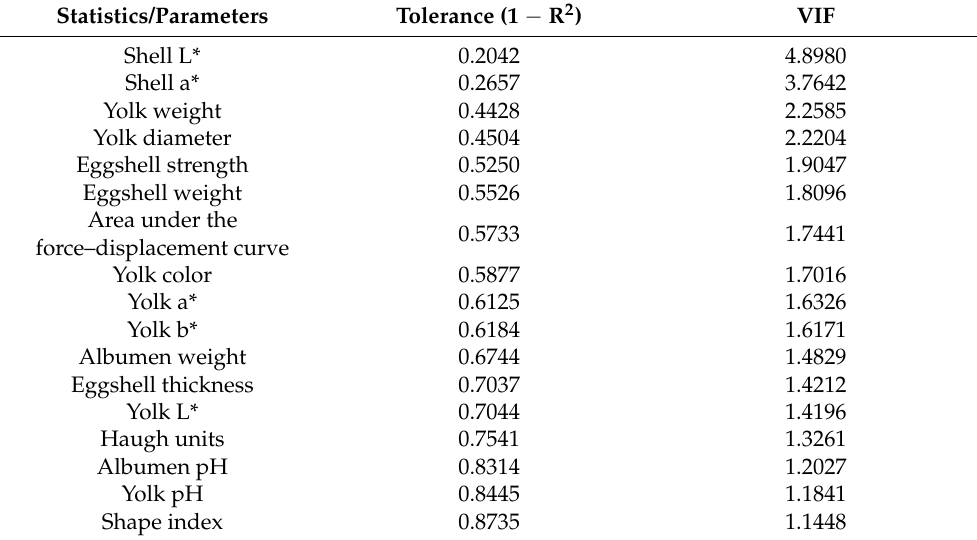
Table 3. Multicollinearity analysis of quality-related traits of eggs to discard for redundant variables.